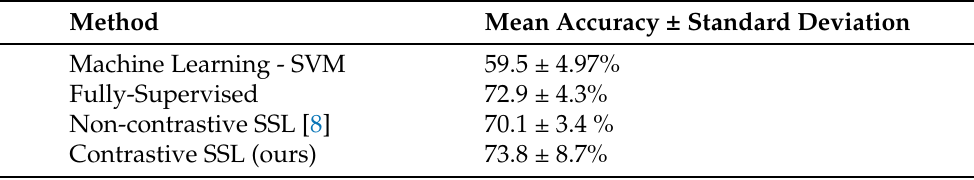
Table 3. Our results compared with supervised baseline and prior works on the RML dataset. All of the experiments presented in this table use a 10–90 test–train split.